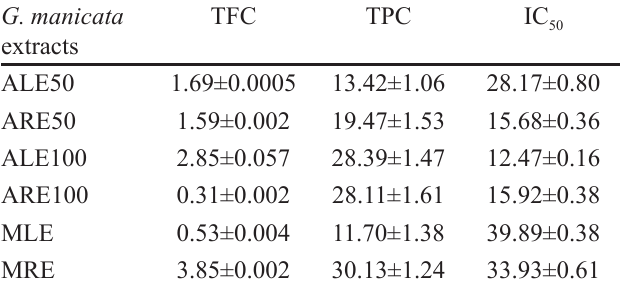
TABLE II - Total Flavonoid Content (TFC) (g% of extract),